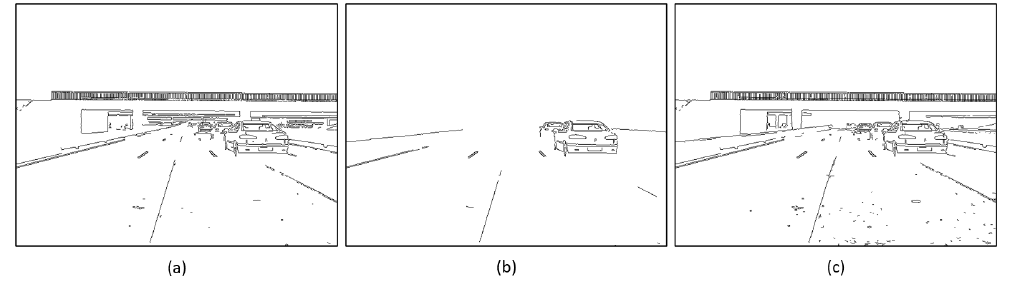
Figure 12. Edge maps after application of the Canny filter on a FRIDA image: ( a ) without fog, ( b ) with fog, ( c ) after restoration. The min and max thresholds of the edge detector are set to 120 and 180.